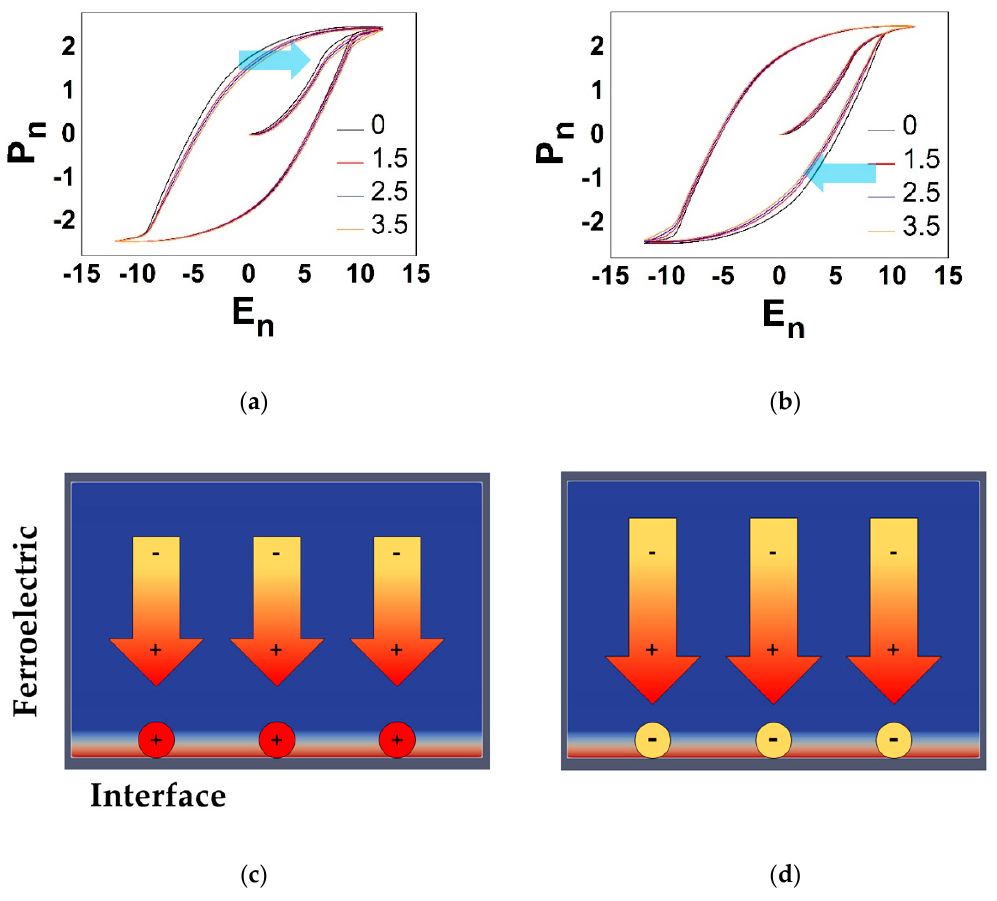
Figure 5. Polarization versus electric field (P–E) curves for the Zr doped HfO 2 (HZO) capacitor with or without an interface trap layer: ( a ) negatively charged interface trap, and ( b ) positively charged interface trap. Various values of interface trap density are employed (1.5, 2.5, 3.5, i.e., 1.4 × 10 12 C / cm 2 , 2.34 × 10 12 C / cm 2 , 3.28 × 10 12 C / cm 2 , respectively). The polarization (arrow) switching under the positive and negative interface trap (circle) charge is illustrated (see Figure 5c,d, respectively).